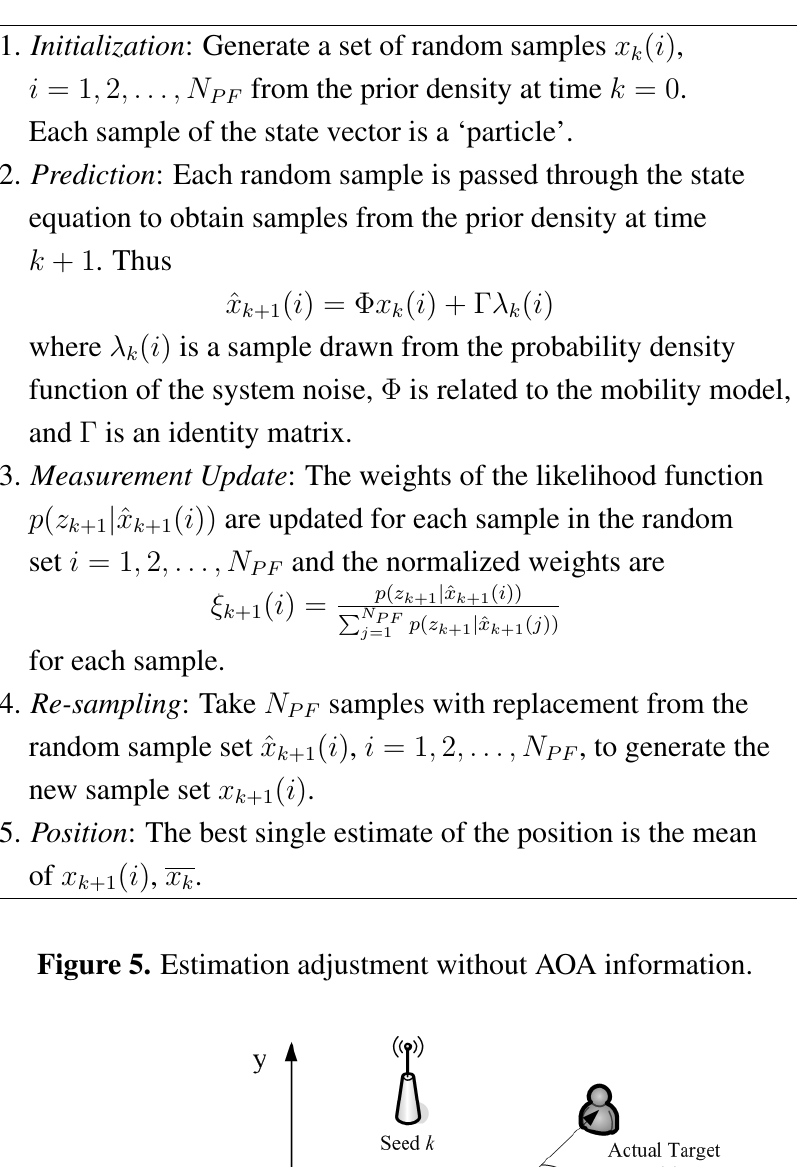
Table 1. The Particle Filtering Methodology.